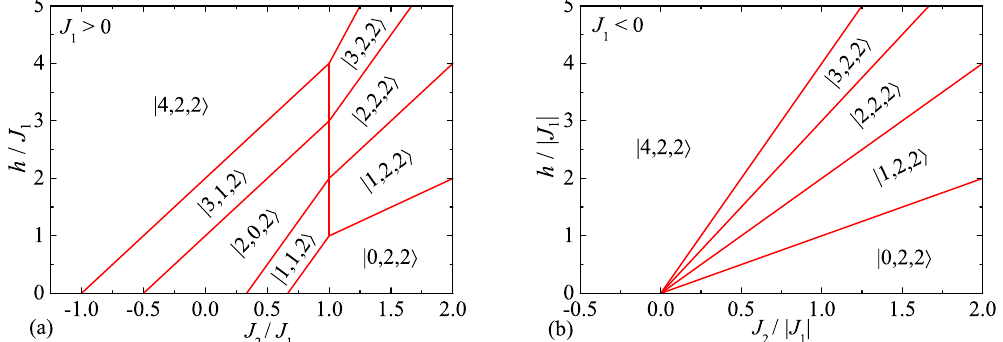
Figure 2. The ground-state phase diagram of the spin-1 Heisenberg diamond cluster in the J 2 / | J 1 | − h / | J 1 | plane for two particular cases with: ( a ) the antiferromagnetic interaction J 1 > 0; ( b ) the ferromagnetic interaction J 1 < 0. The eigenvectors | S T = S z to the quantum spin numbers determining the total spin and its z -component S T = S z as two composite spins S 12 and S 34 formed by spin-1 entities from opposite corners of a diamond spin